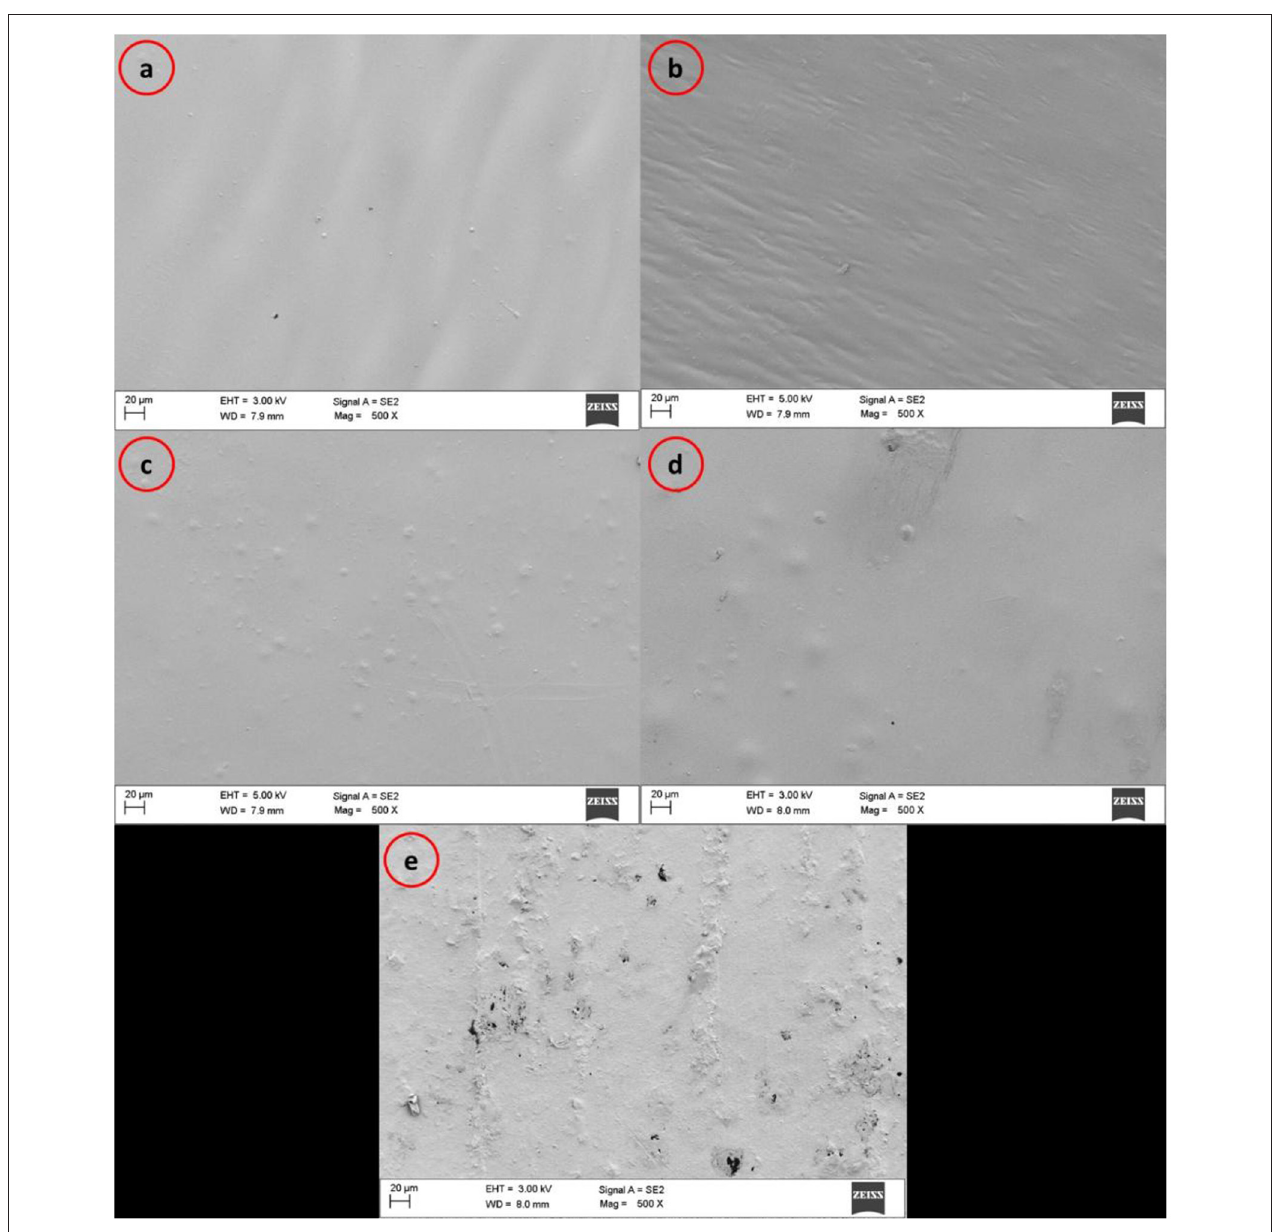
FIGURE 4 | SEM micrographs of surfaces of (a) commercial PLA films (PLA-C), (b) PLA films manufactured from fermentation process (poly(L-lactic acid) (PLLA)), (c) PLLA-1% CNPs, (d) PLLA-3% CNPs, (e) PLLA-5% CNPs.